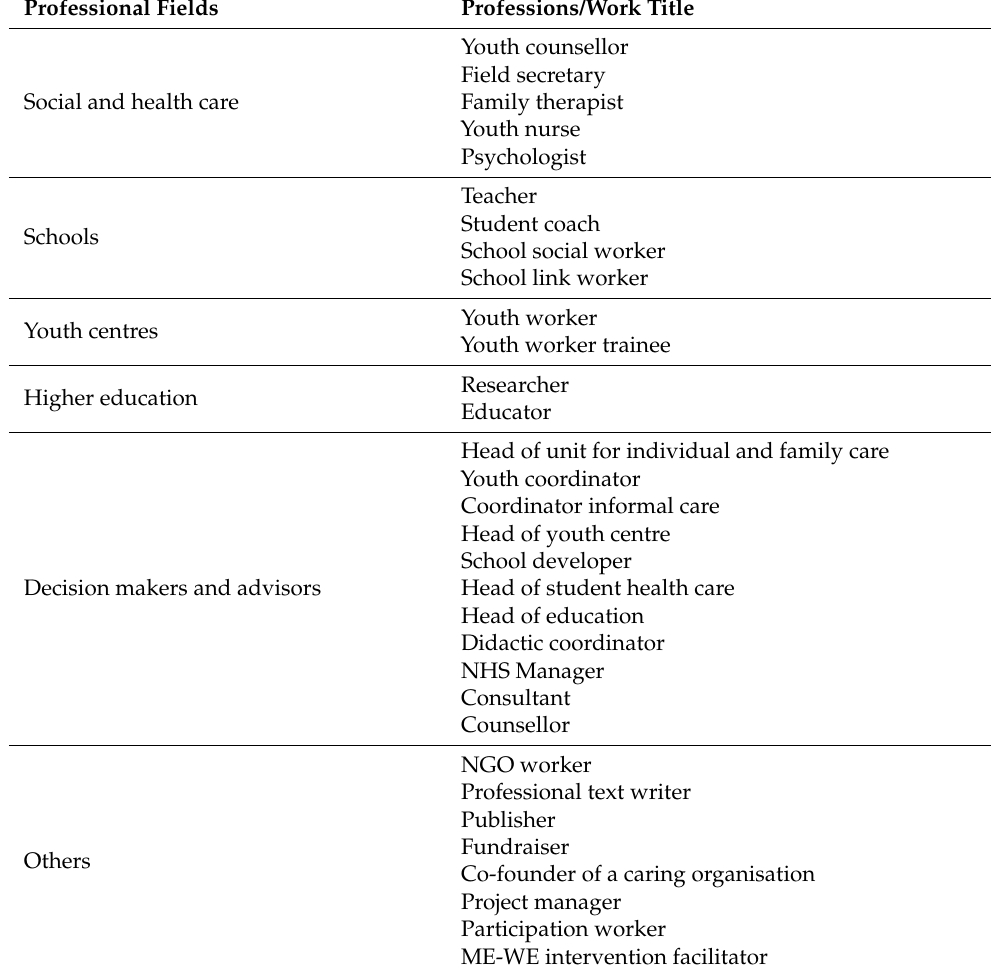
Table 8. Stakeholders’ professional fields and professions.